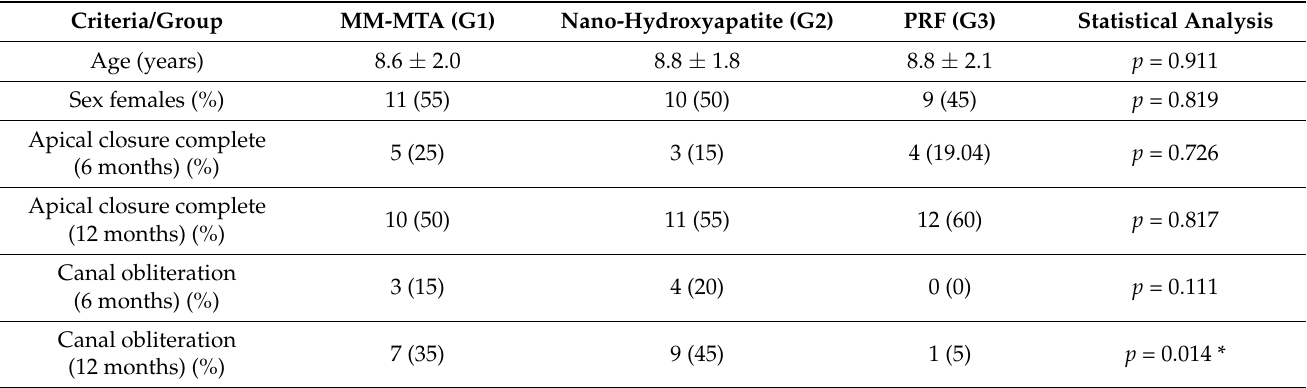
Table 1. Age, sex and radiographic evidence of root canal growth in the three tested group at 6- and 12-month follow-ups. * p <